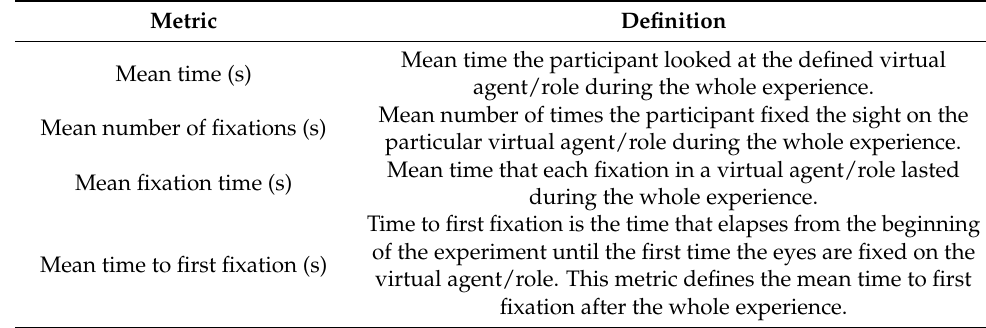
Table 2. Eye-tracking metrics extracted during the serious